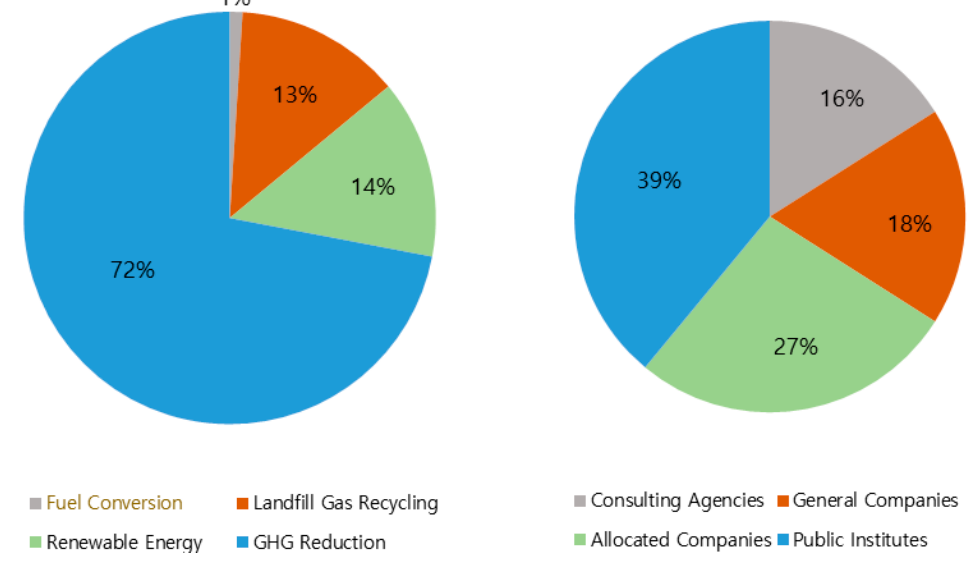
Figure 6. The amount of certified emission permits by project type and by enterprise type. Source: Ministry of Strategy and Finance